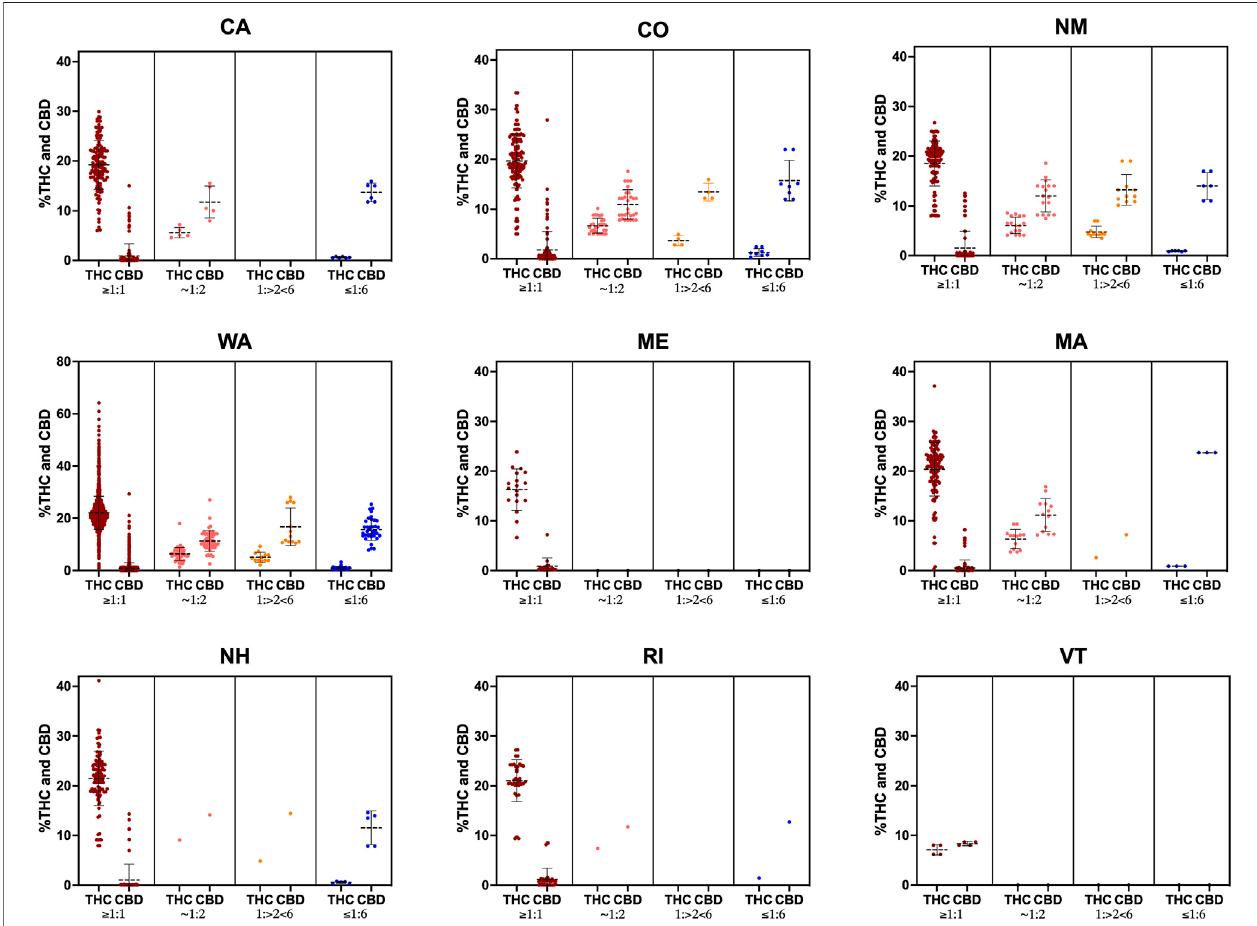
FIGURE 3 | THC and CBD percent distribution by ratio category for all products with > 0% CBD in each state. Data shown as mean ± SD.